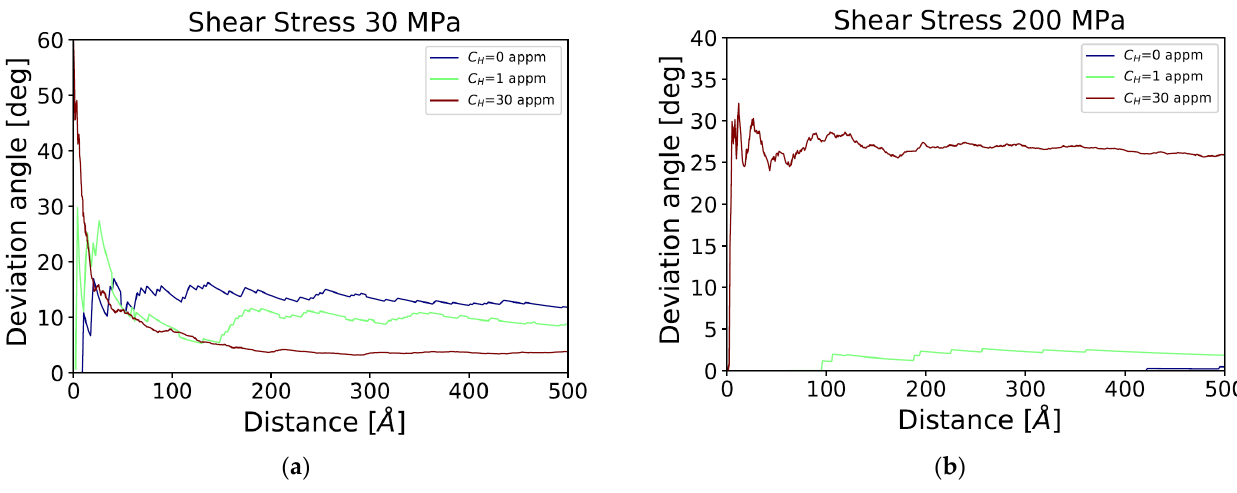
Figure 10. Deviation of the dislocation from the primary slip plane at an applied stress ( a ) τ = 30 MPa and ( b ) 200 MPa as a function of the average distance.